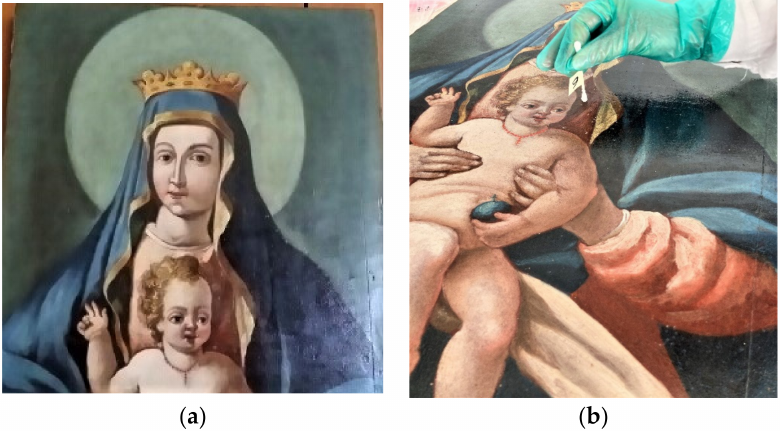
Figure 11. ( a ) Historical wood paintings, “ Madonna con Bambino ”, originally located in the Santa Maria del Lago church, chosen for the ex situ study. ( b ) Sampling phase used sterile cotton swabs for microbiological analyses, with permission of the Bishop in charge of the Cathedral-Bishop’s Curia,